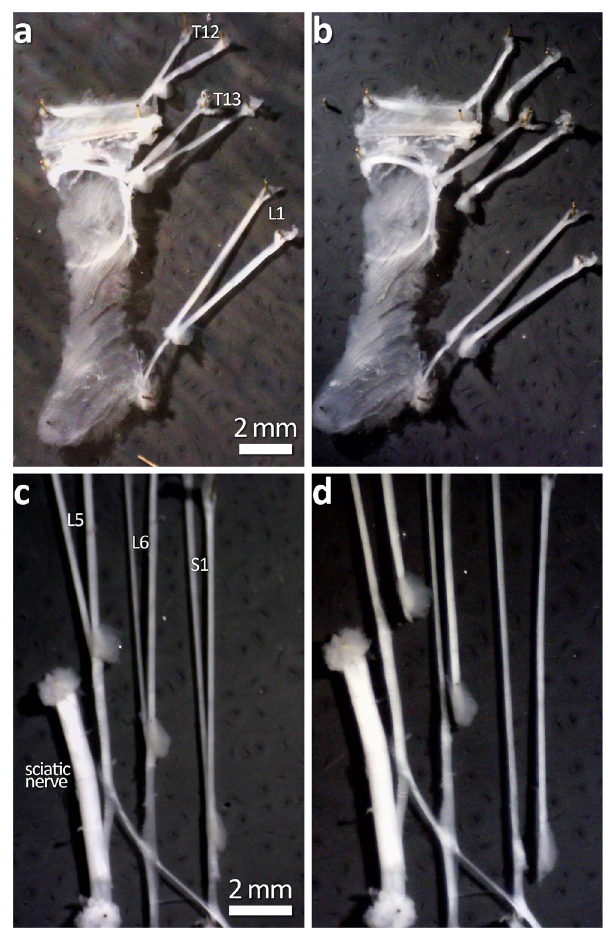
Fig. 3 Ex vivo demonstration of dorsal root section prior to DRG removal. a , b Dorsal root section of T12-L1. c , d Dorsal root section at L5-S1. This step is shown here in this way as the in vivo procedure gives little visual con fi rmation after the section of the root. Following this step, DRG are removed completely by cutting it away from the dorsal root, leaving the ventral root